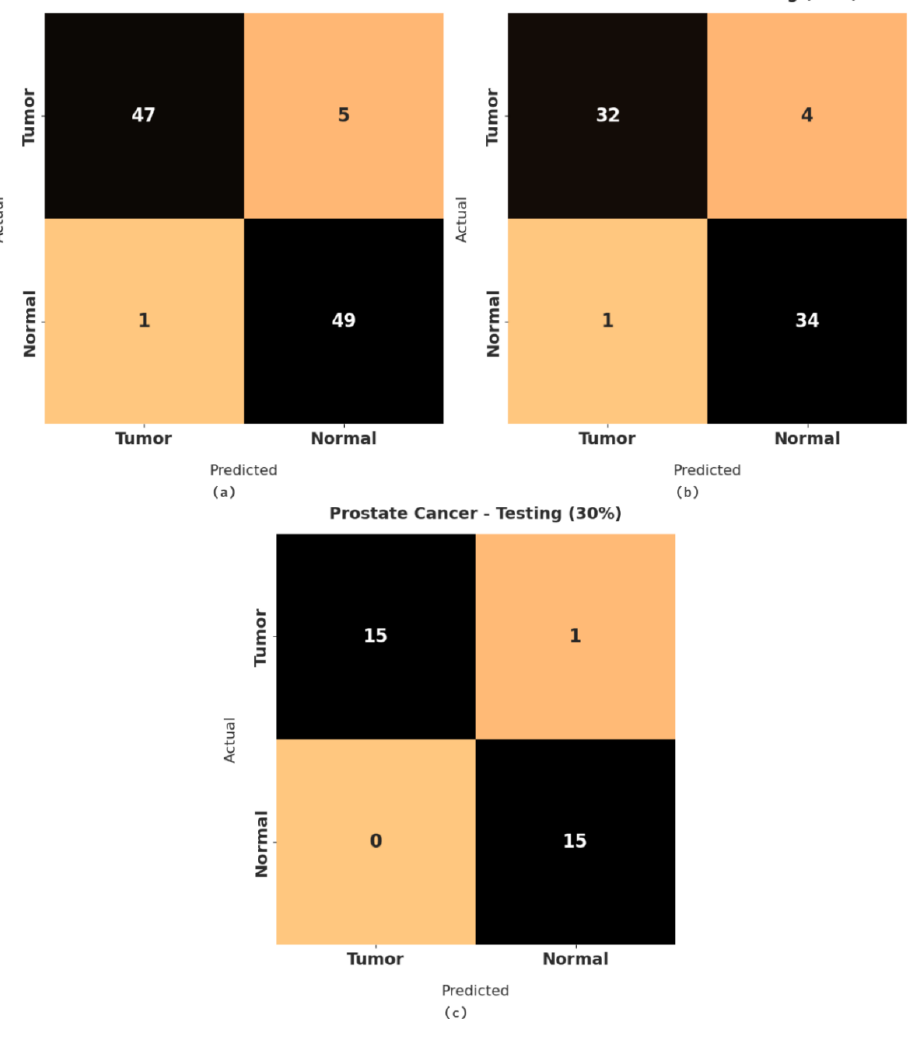
Figure 3. Confusion matrices of RFODL-MGEC technique for prostate cancer dataset. ( a ) Entire dataset, ( b ) 70% of training dataset, and ( c ) 30% of testing dataset